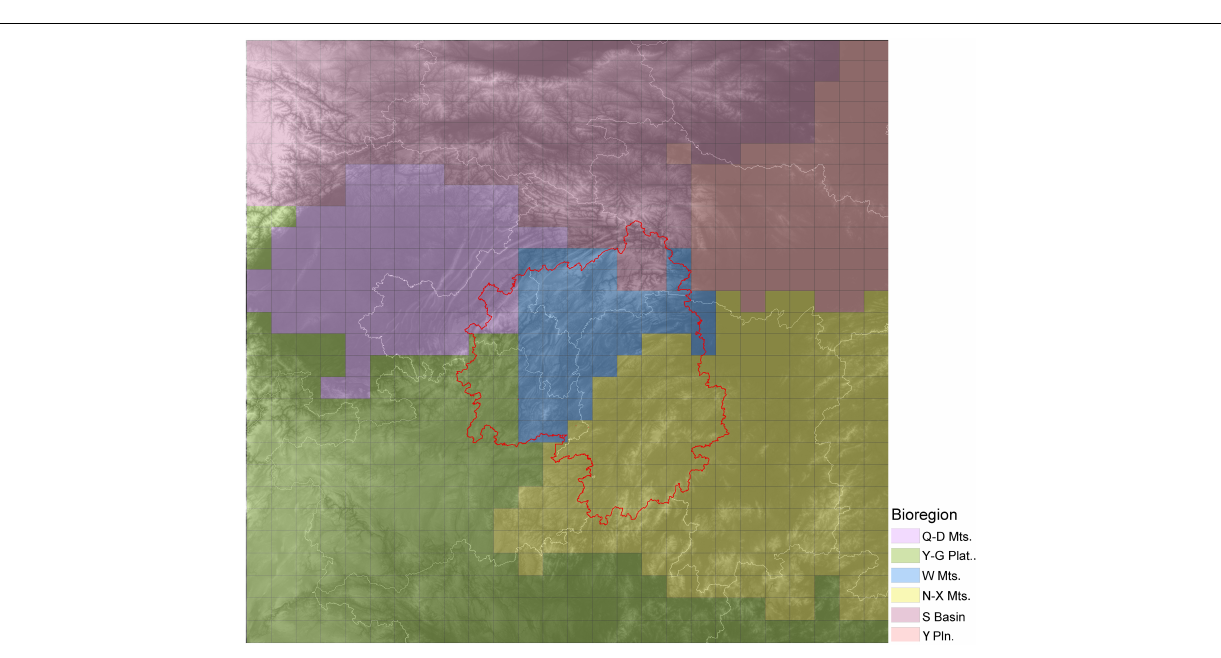
FIGURE 5 | Biodiversity regions within the study area as determined for woody plant species. Different colors indicate different bioregions. The base graphic is a topographic map, and the red line delineates the Wuling